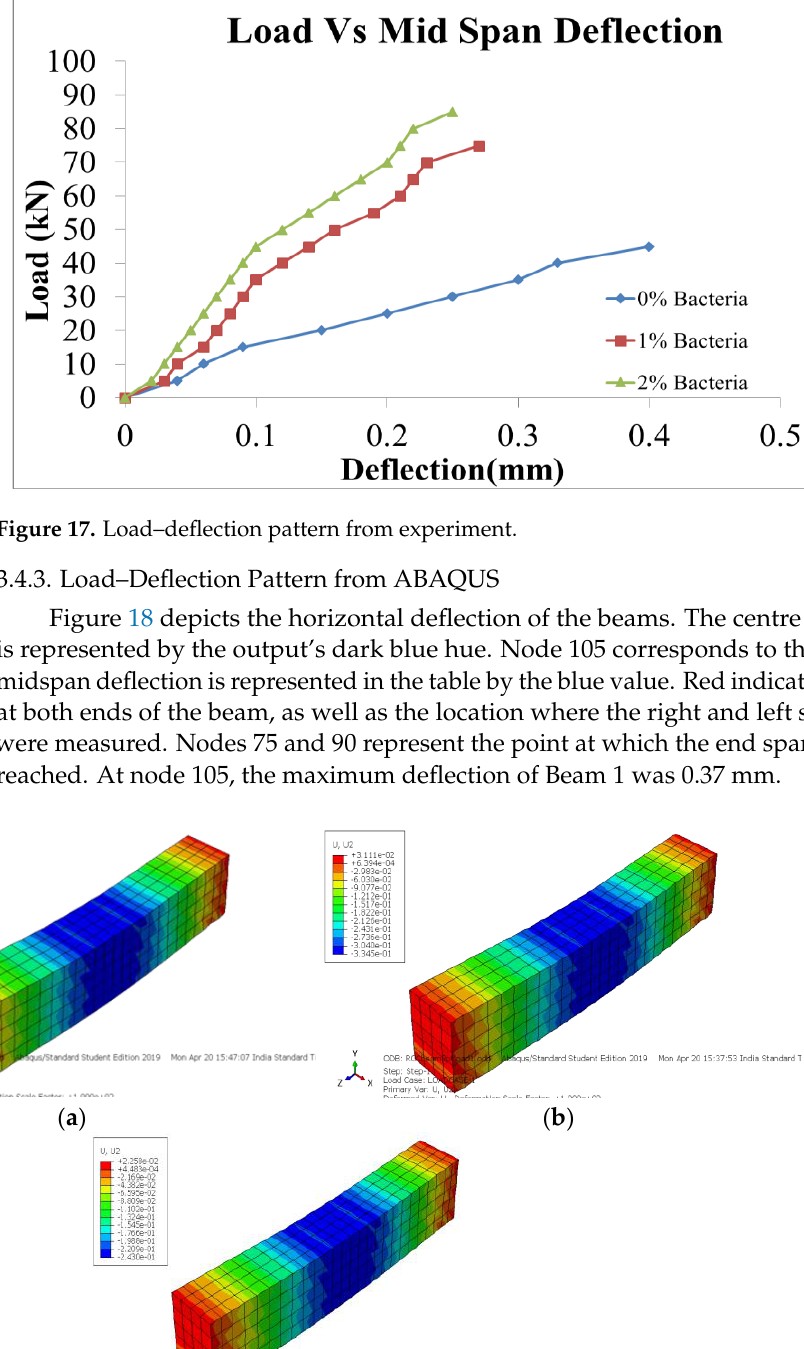
Figure 17. Load – deflection pattern from experiment.